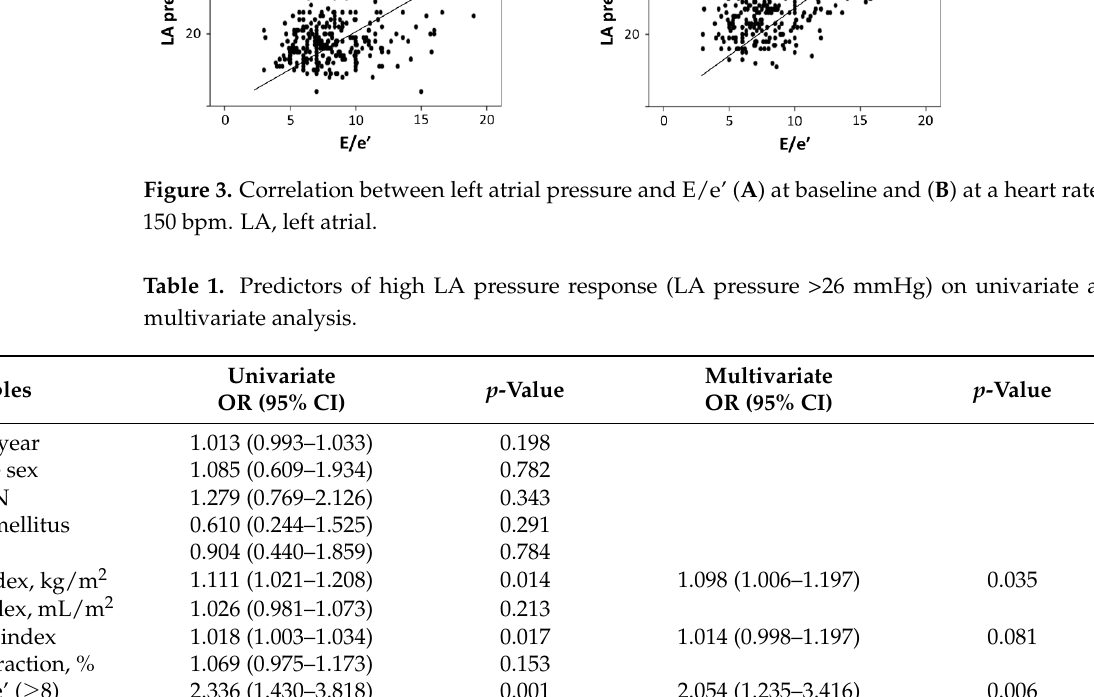
LAP increased with incremental atrial pacing. The LAPR was not correlated with the presence of AF but was closely related to E/e’, an echocardiographic marker of LV diastolic dysfunction. 4.1. The Mechanism of LA Hypertension LAP is influenced by several factors such as LV systolic and diastolic function, LA chamber stiffness, and intravascular volume status. If LV diastolic function worsens, LV end-diastolic pressure (LVEDP) increases to maintain adequate LV stroke volume [8] . The LA is directly exposed to LV pressure during its diastolic phase. The filling of the LA during the LV systolic phase produces high LAP, which leads to increased LA wall tension and remodeling. LAP reflects both LA remodeling in chronically increased LVEDP exposure and pressure loading through the mitral valve. It can be used to investigate the prognosis of HF. Increased LAP causes electrical heterogenicity of the atrial myocardium, which causes AF [9,10] . AF is a result as well as an aggravating factor of HF. We hypothesized that LAP and LAPR were increased in patients with AF, but there was no significant difference in the results. First, the degree of diastolic dysfunction was not significantly different between the AF and control groups. E/e’ was statistically different, but the absolute values were not clearly different. Many subjects with relatively mild HF were included because patients with AF are candidates for ablation. Second, the dilated and remodeled atria compensate for the pressure change. 4.2. The Clinical Implication of LAPR LAP does not increase at the normal range of heart rate but increases rapidly beyond its threshold. This means that insufficient time to fill the appropriate volume leads to an increase in LVEDP. In our study, LAPR was closely related to E/e’ regardless of the rhythm status. These results imply that the main factor of LAPR is LV diastolic